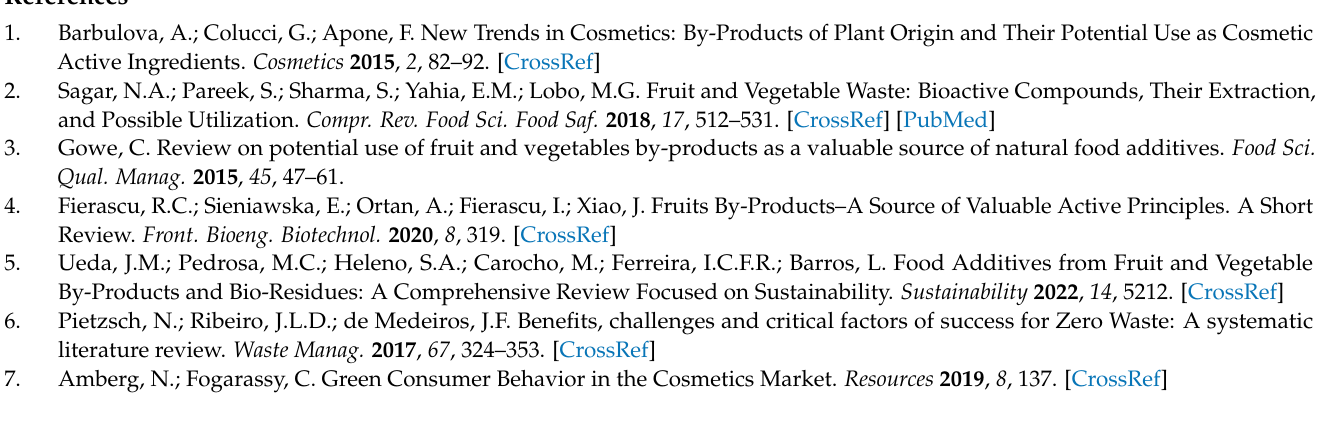
Table S2. The selected MS/MS fragmentation spectra of the tentatively identified